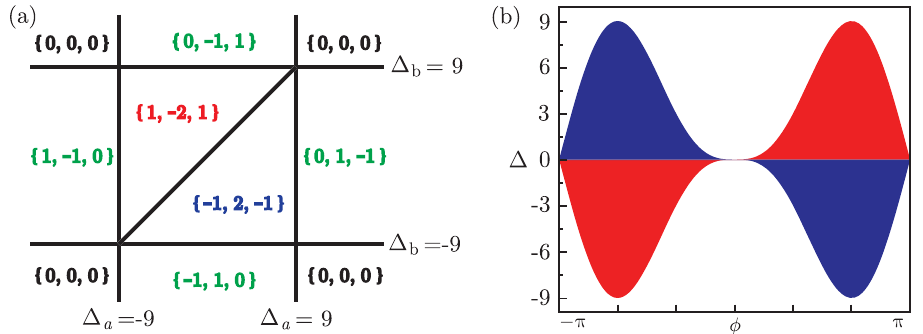
Figure 2. ( a ) Phase diagram of isotropic case φ π = 2 /3 labeled by {x, y, z}, respectively. ( b ) Topological nontrivial regions with boundaries φ φ |Δ| = | − | 4 3 sin (1 cos ) , red for {1, − 2, 1} and blue for { − 1, 2, − 1}, where Δ = −Δ a = Δ b and